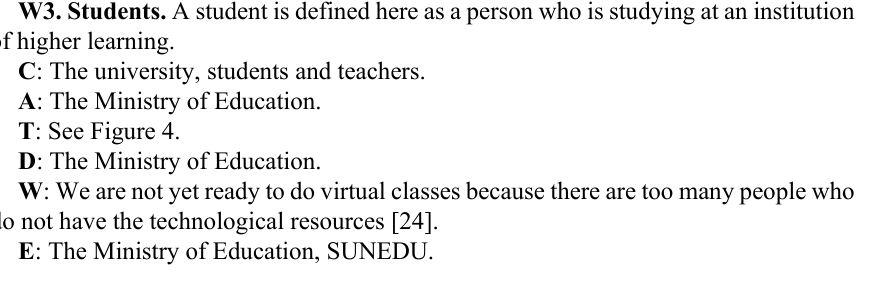
Fig. 3. SUNEDU's evaluation of universities and